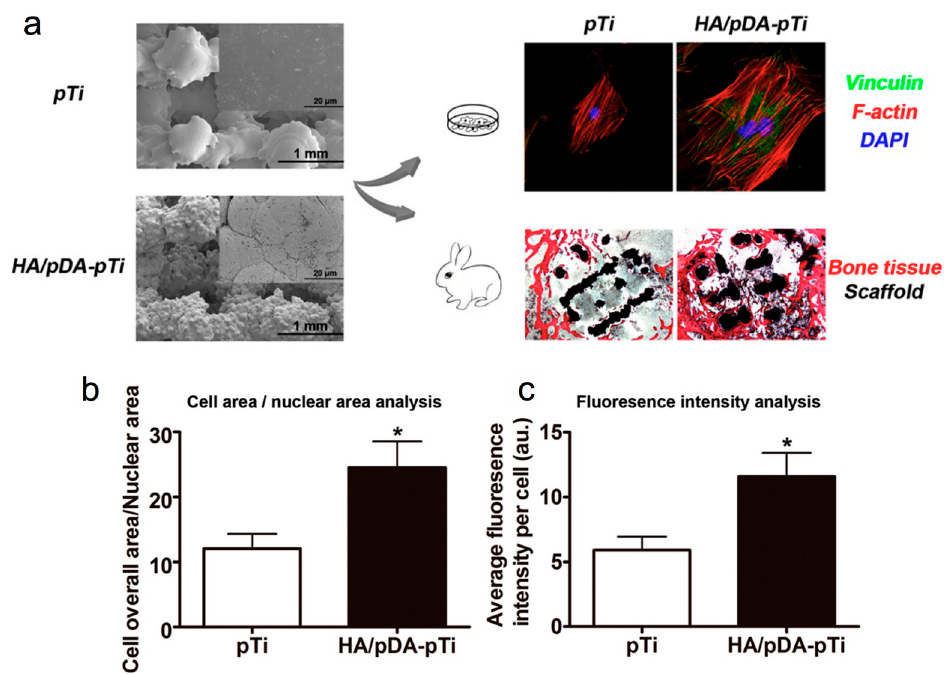
Figure 5. ( a ) Scanning electron microscopic (SEM) images of bare porous Ti6Al4V scaffolds (pTi) and polydopamine-assisted hydroxyapatite coating on titanium surfaces (HA/pDA-pTi). Fluorescent staining of MC3T3-E1 cells adhered to pTi and HA/pDA-pTi scaffolds, and ( b ) analysis of morphology of SEM images as shown in panel a and ( c ) fluorescence intensity of vinculin staining for cells on different scaffolds. Asterisks (*) indicate statistical significance compared to the pTi group, p < 0.05). Reprinted with permission from reference [55]. Copyright (2015) American Chemical Society